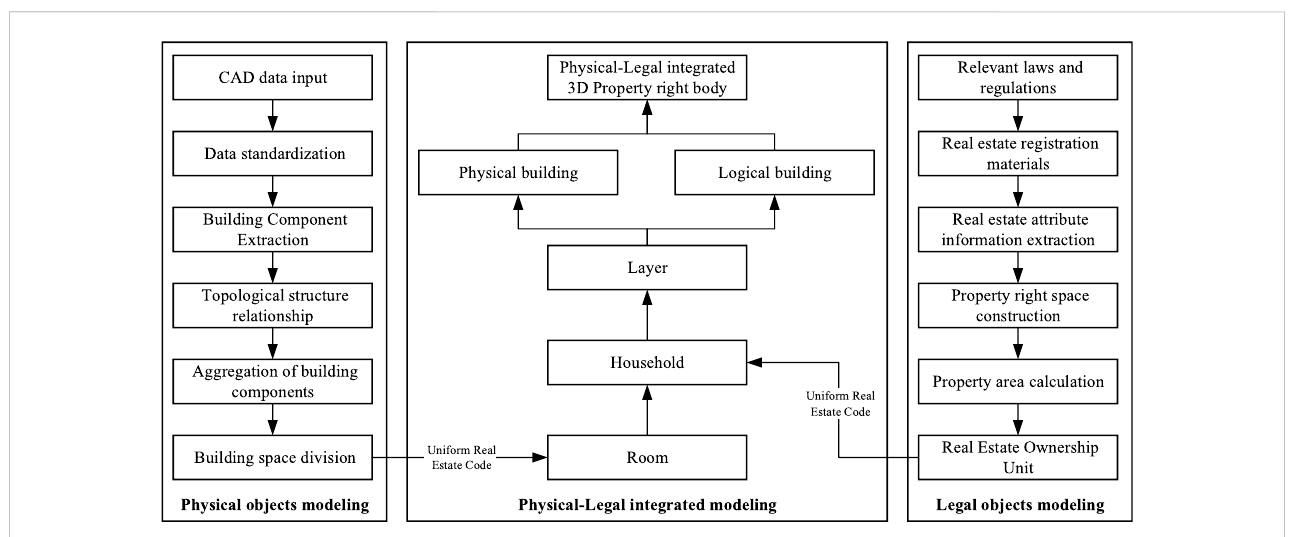
FIGURE 7 Roadmap of real estate multi-level property model integrating physical and legal information.